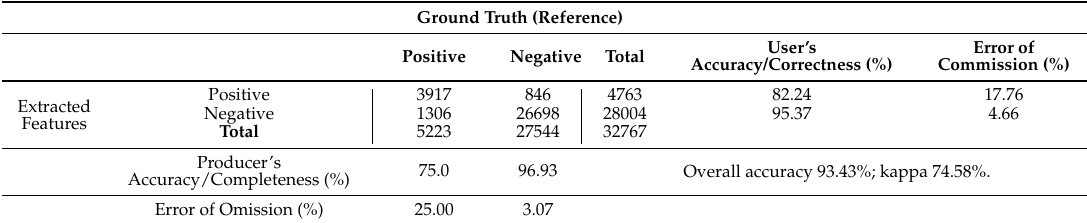
Table 2. Confusion (error) matrix for assessing the quality of extracted landslide scarps based on the topographic Eigenvalue ratios approach.